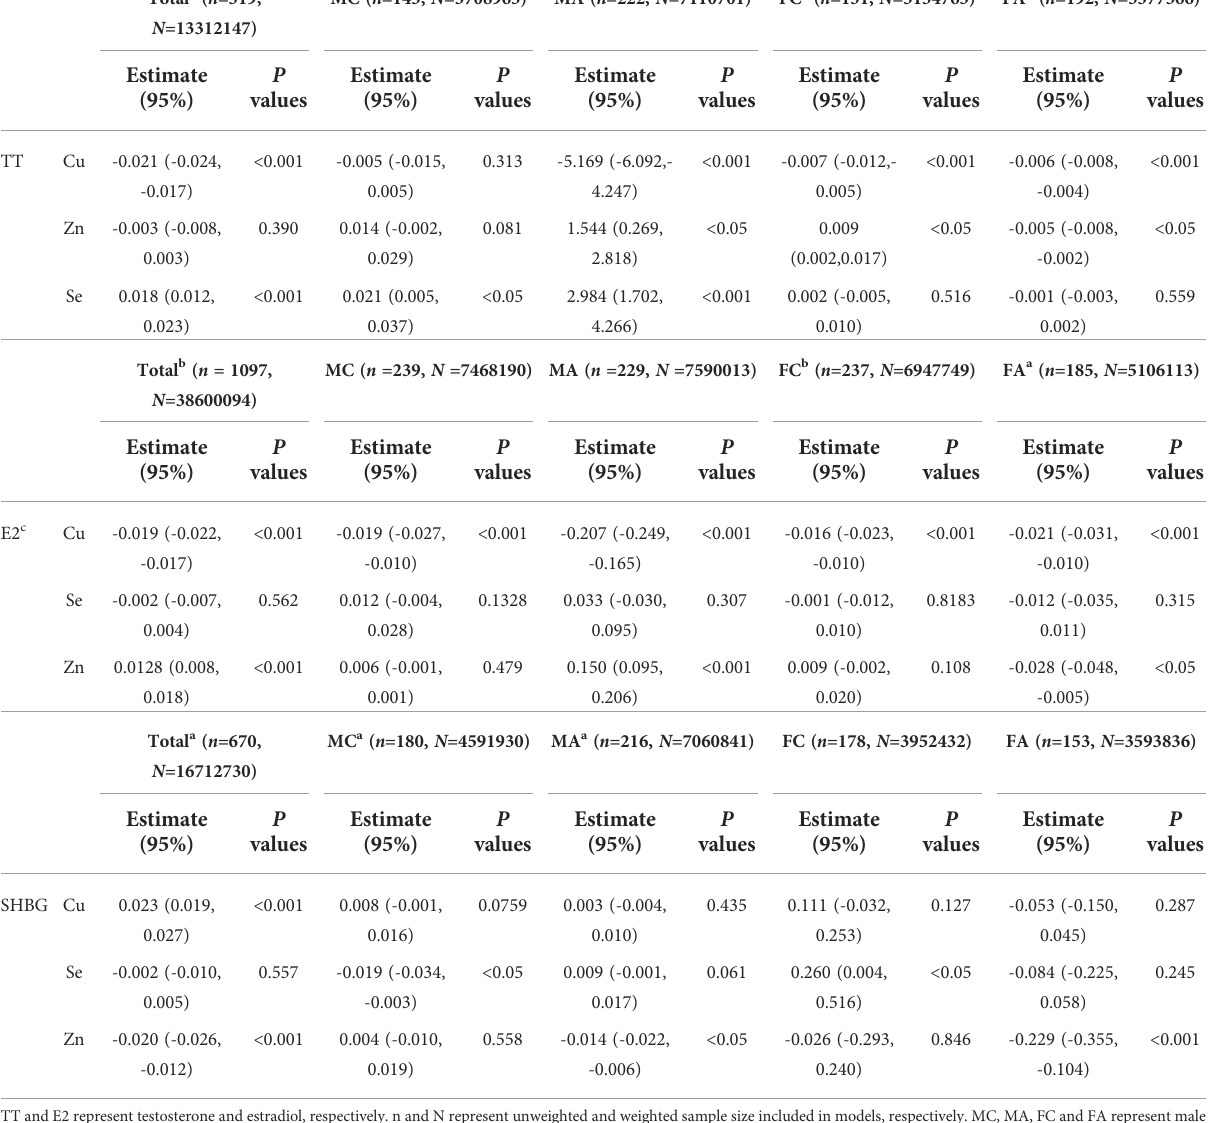
TABLE 3 Associations between sex hormones and trace